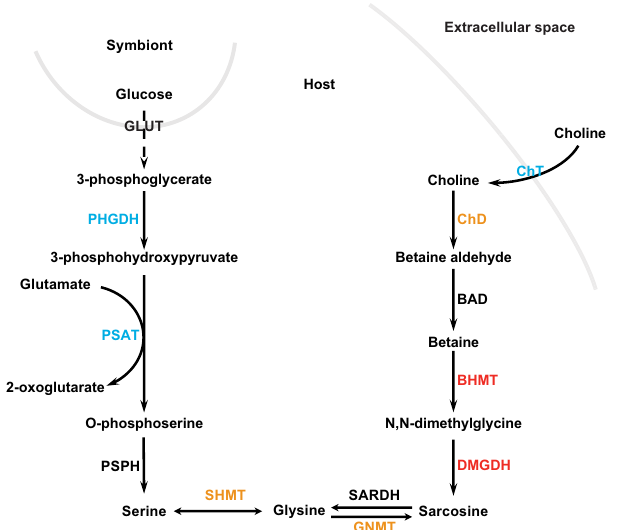
Fig. 6 Pathway for glycine and serine biosynthesis in CC7-B01 response to heat stress. In a stable symbiosis, symbiont-produced carbohydrates are a main source of carbon backbones for the synthesis of nonessential amino acids in the cnidarian host (left side). In contrast, pathways using food- derived choline and betaine for amino acid biosynthesis are down-regulated (right side). During stress exposure, the stable state of the symbiosis shifts to a carbon-limited state, resulting in increased dependency of the host on external carbon sources. In response, the amino acid biosynthesis pathway using food-derived carbon sources is now up-regulated, while the pathway relying on symbiont-derived glucose is down-regulated. Colours represent the direction of expression change: dark red – signi fi cantly up-regulated, orange – up-regulated, dark blue – signi fi cantly down-regulated, light blue down-regulated (GLUT – glucose transporter, PHGDH – phosphoglycerate dehydrogenase, PSAT – phosphohydroxythreonine amino- transferase, PSPH – phosphoserine phosphatase, SHMT – serine hydroxymethyltransferase, ChT – choline transporter, ChD – choline dehydrogenase, BAD – Bcl2 associated death promoter, BHMT – betaine — homocysteine S-methyltransferase, DMGHD – dimethylglycine dehydrogenase, GNMT – glycine N- methyltransferase, SARDH – sarcosine dehydrogenase) 14